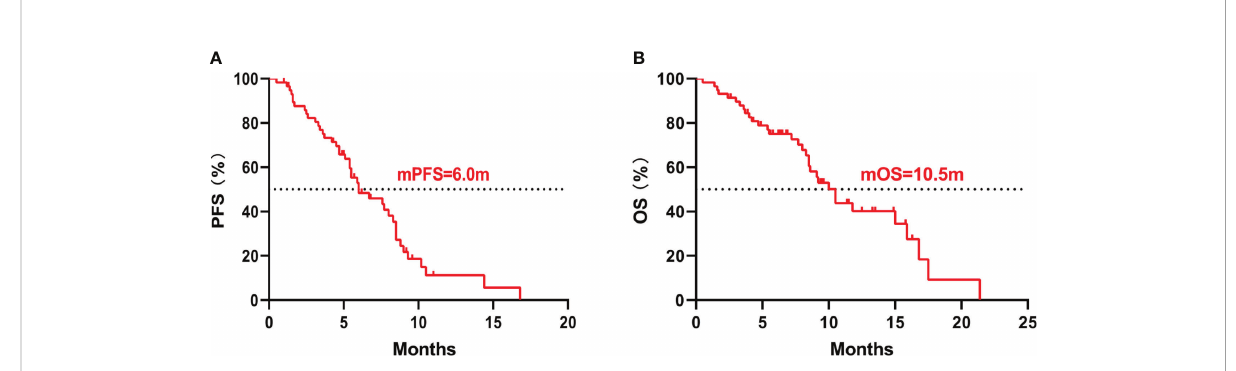
FIGURE 1 Kaplan – Meier curves of all patients. (A) The Kaplan – Meier curve of PFS; (B) The Kaplan – Meier curve of OS. PFS, progression-free survival; OS, overall survival.